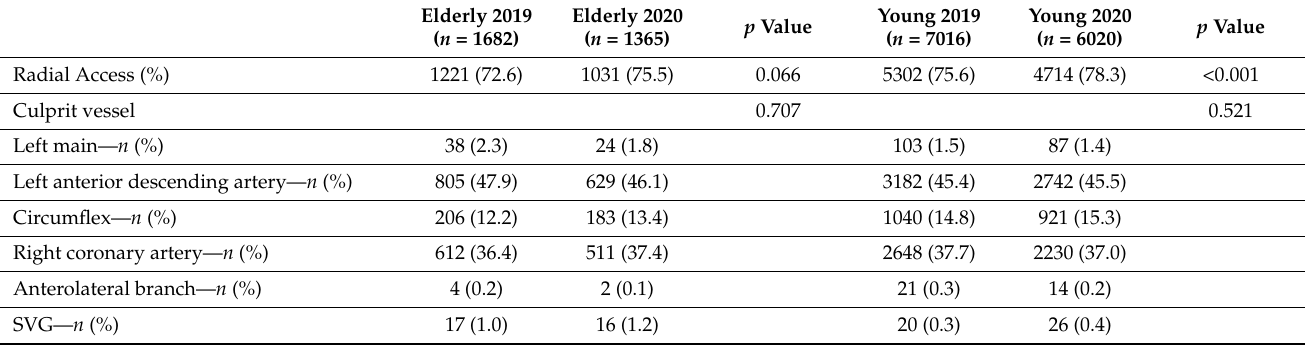
Table 2. Angiographic and procedural